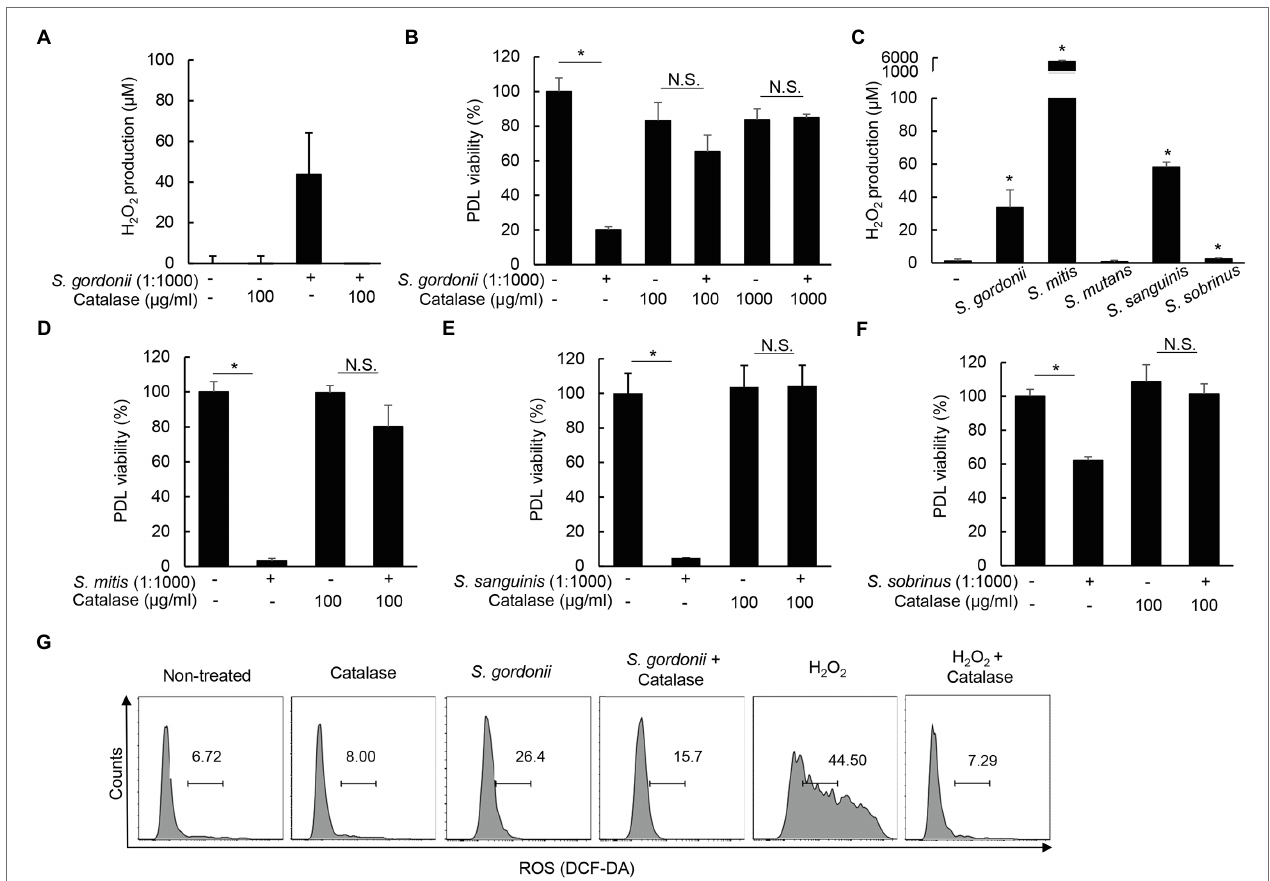
FIGURE 5 | Streptococci -induced cytotoxicity of PDL cells is mediated through production of H 2 O 2 . (A) PDL cells were treated with S. gordonii at MOI 1:1,000 in the presence or absence of catalase (100 μ g/ml) for 1 h. The level of H 2 O 2 in the supernatant was determined using a hydrogen peroxide assay kit. (B) PDL cells were treated with S. gordonii at MOI 1:1,000 in the presence or absence of catalase (100 or 1,000 μ g/ml) for 3 h. Trypan blue assay was used to determine the number of viable cells. (C) PDL cells were treated with S. gordonii, S. mitis, S. mutans, S. sanguinis, or S. sobrinus at MOI 1:1,000 for 1 h. The level of H 2 O 2 in the supernatant was determined using a hydrogen peroxide assay kit. (D–F) PDL cells were treated with S. mitis, S. sanguinis, or S. sobrinus in the presence or absence of catalase for 3 h. Trypan blue assay was used to determine the number of viable cells. (G) PDL cells were treated with 10 μ M of DCF-DA for 30 min at 37 ° C. DCF-DA-treated cells were washed with PBS and then treated with S. gordonii at MOI 1:1,000 or H 2 O 2 in the presence or absence of catalase for 3 h. Fluorescent intensity was analyzed by flow cytometry. One of three similar results is shown. * p <